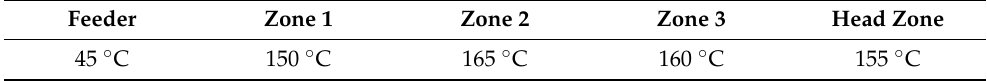
Table 1. Extrusion temperature profile adopted for the PBSA/BC composites.